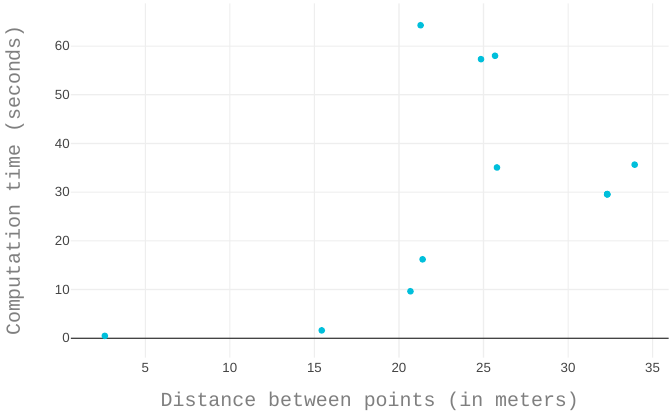
Figure 11. The computation time of the paths generated in real time, onboard during